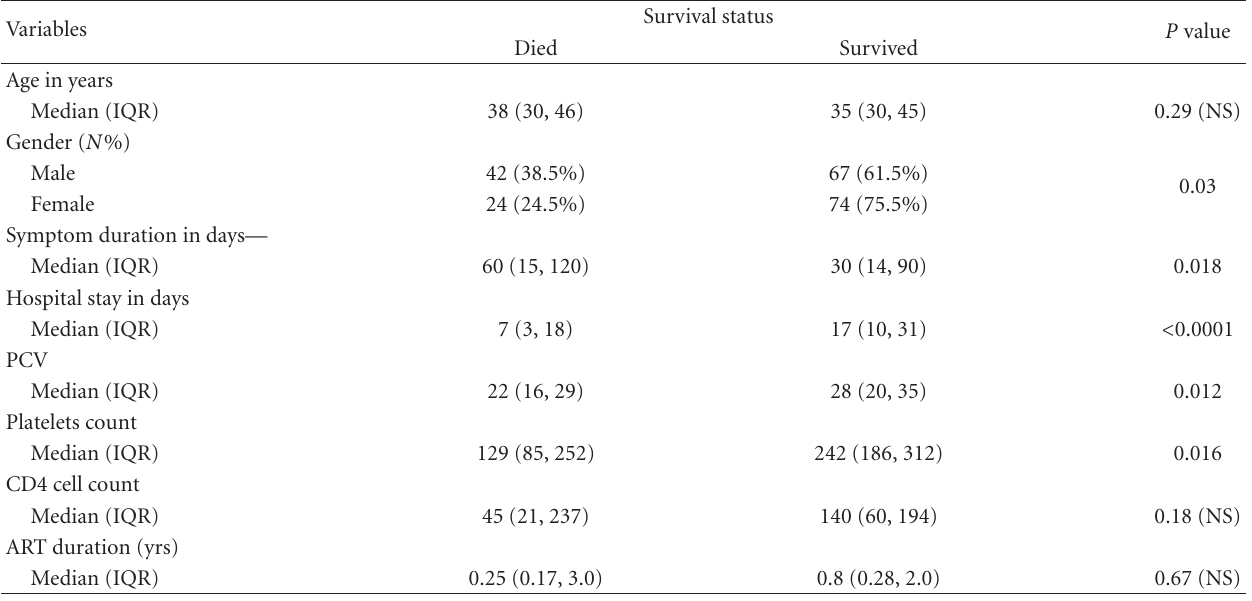
Table 5: Comparisons of demographic and clinical variables in relation to survival outcome of HIV/AIDS patients.